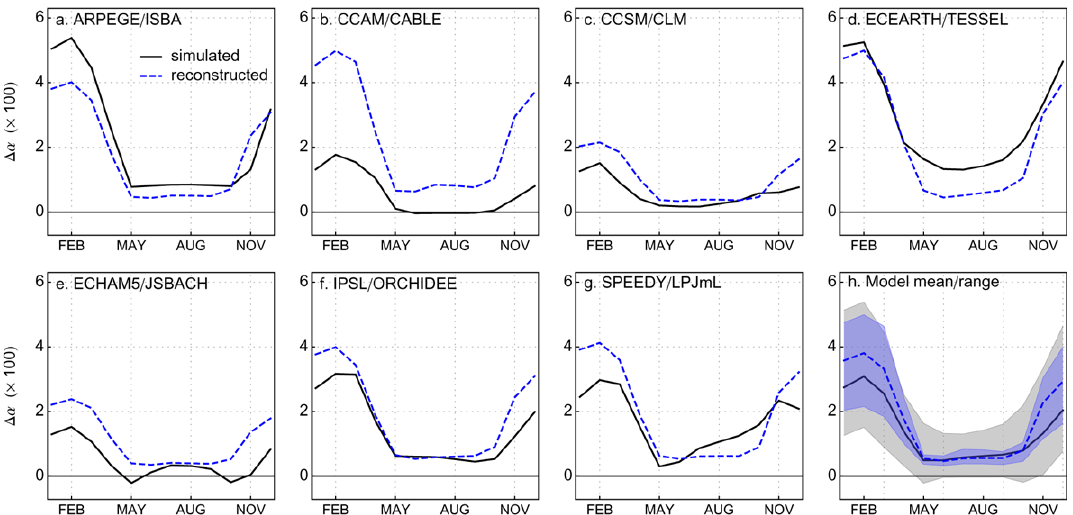
Fig. 7. Monthly mean surface albedo response to LCC (present-day minus preindustrial) averaged over the region of study (box in Fig. 5). Solid and dashed lines illustrate respectively the simulated and the reconstructed albedo changes for each LUCID GCM/LSM (a–g) . Panel (h) indicates the inter-model mean and range (shading) of the simulated (solid line and gray shading) and reconstructed (dashed line and blue shading) albedo